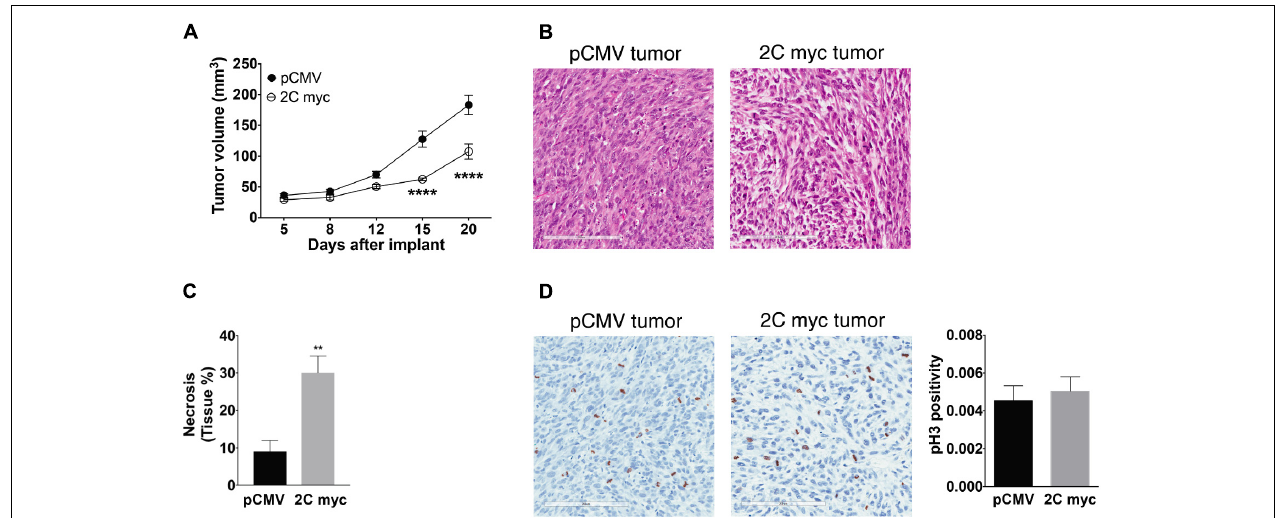
FIGURE 9 | Ectopic expression of LAMP-2C decreased tumor growth in a xenograft mouse model. NSG mice were implanted subcutaneously in the flanks with 5 × 10 5 DM331 cells with or without ectopic LAMP-2C myc expression. (A) Tumor growth was monitored biweekly ( n = 13 per group). (B) Representative HE staining of primary control tumor or primary tumor with high ectopic expression of LAMP-2C myc. (C) Percentage of necrotic areas of primary tumors were evaluated by HE staining ( n = 5 per group). (D) Representative pH3 staining of primary tumor with or without LAMP-2C myc expression. To determine changes in mitosis, pH3 positive cells were quantified in five hot spots areas of primary tumors. pH3 positivity was quantified dividing the number of pH3 positively stained cells by the total number of cells in the selected areas ( n = 6 per group). Data were analyzed by two-way ANOVA or by two-tailed, unpaired Student’s t -test. Error bars indicate mean ± SEM. ∗∗ p < 0.01 and ∗∗∗∗ p <